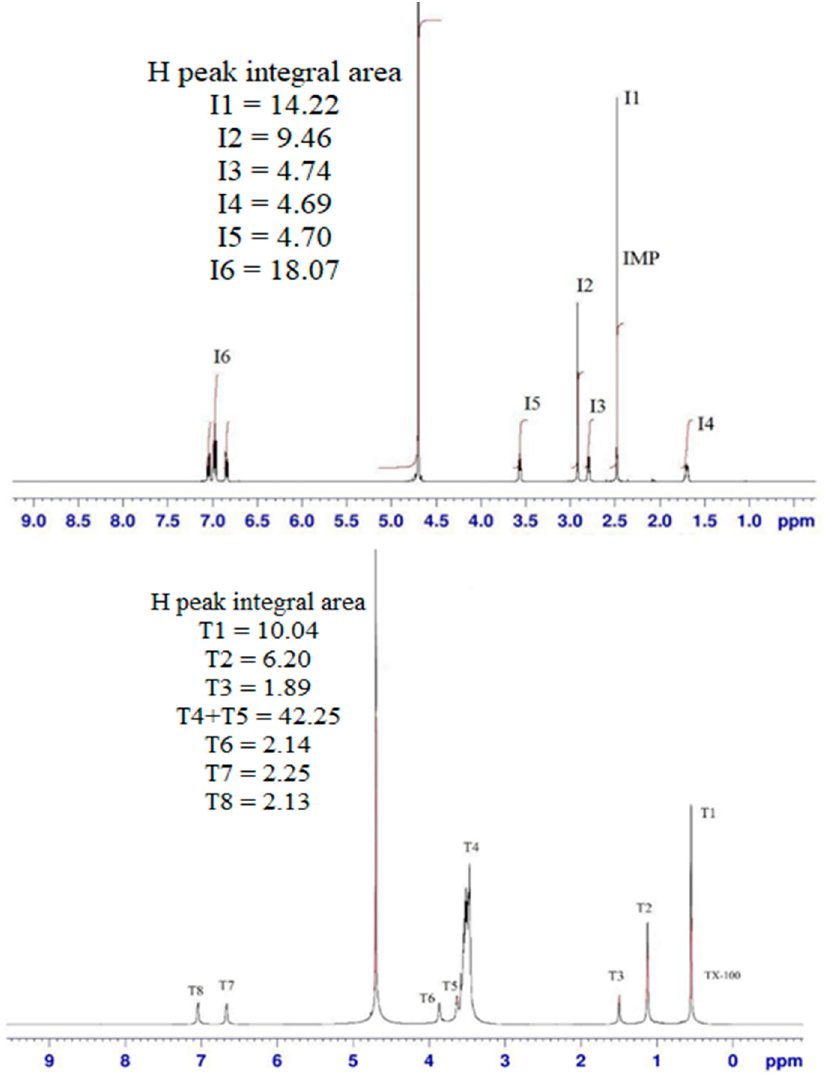
Gels 2022 , 8 , x FOR PEER REVIEW Figure 3. 1 H NMR (600 MHz) spectrum of singular compound IMP drug and TX-100 in D 2 O. Table 3. 1 H NMR chemical shifts ( δ , ppm) of pure IMP and TX-100 in aqueous system. Compound